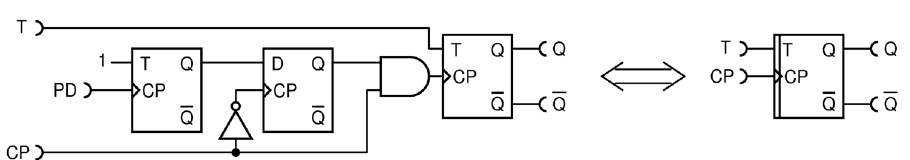
Figure 3. Realization of the T-type random flip-flop (TRFF): T and CP are its inputs, Q and Q are its outputs, while PD is an "internal" input (not shown in the symbol) that receives about 16 Mcps random pulses from a photon detector, situated outside of the FPGA and illuminated by a constant intensity light from an LED. Symbol of a T-type RFF is shown on the right